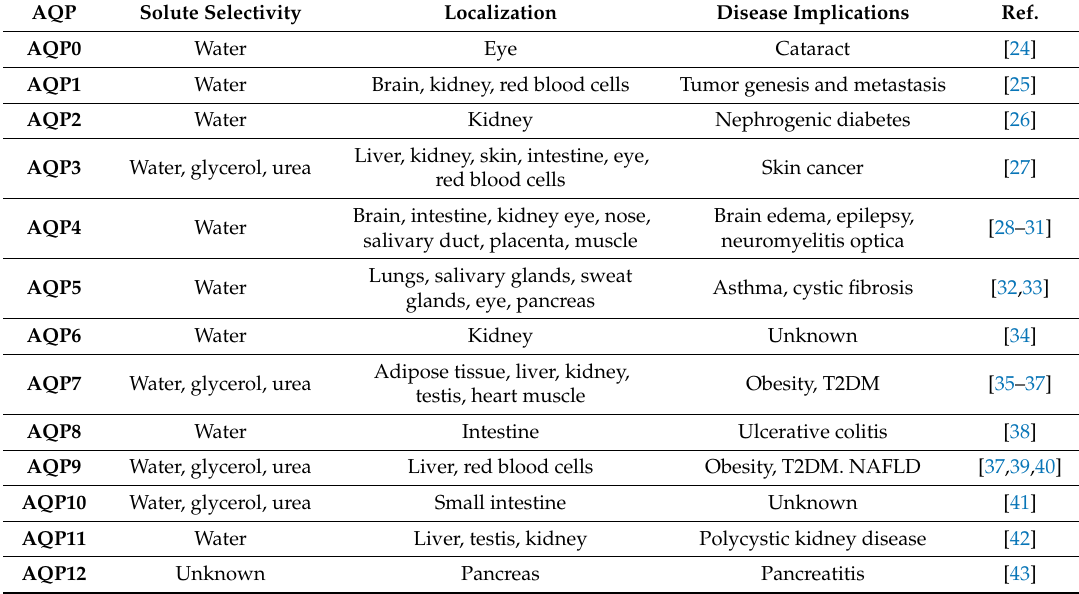
Table 1. Solute selectivity of aquaporins (AQPs), and their localization and disease implications.